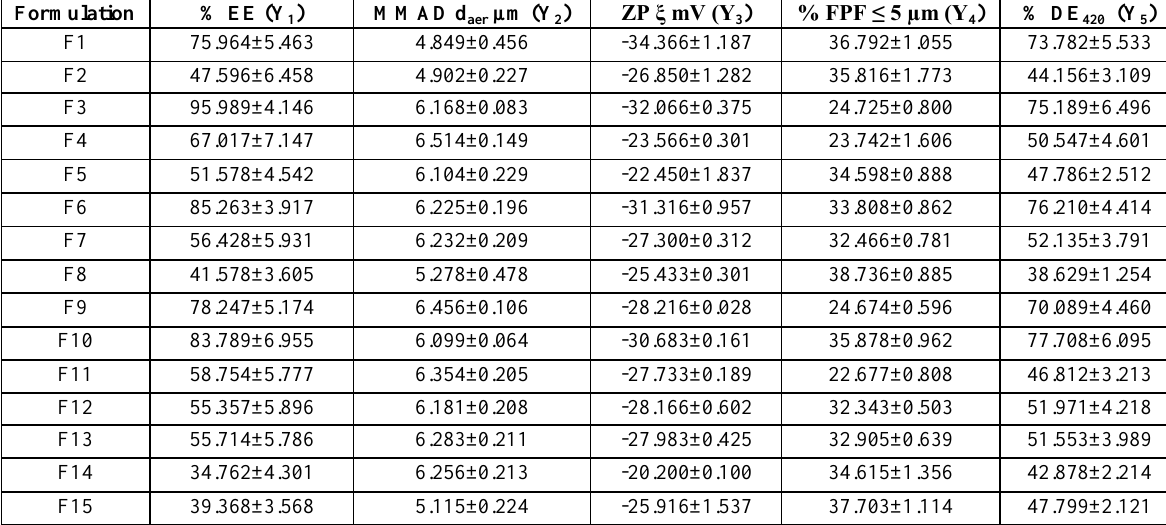
Figure 2: Three incorporation models of drugs in the solid lipid matrix Table 5: Observed responses